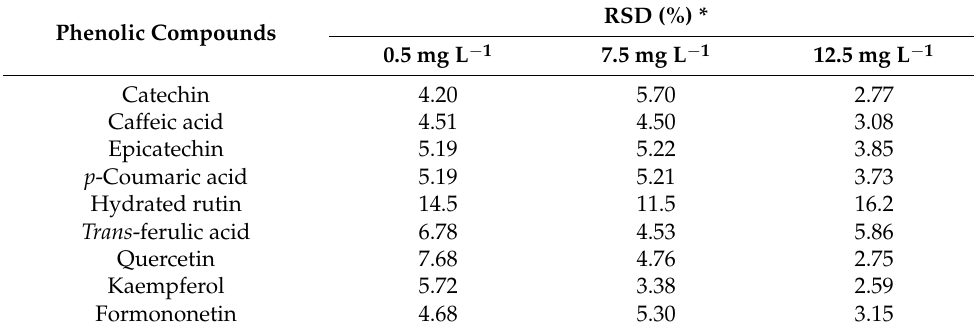
Table 2. Relative standard deviations (RSD) obtained for each phenolic compound in the evaluation of method repeatability (intraday